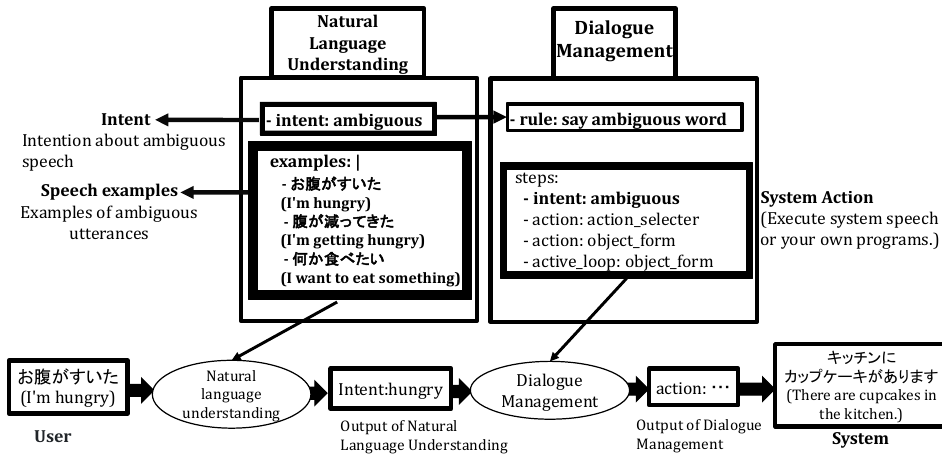
Figure 4. Example of system